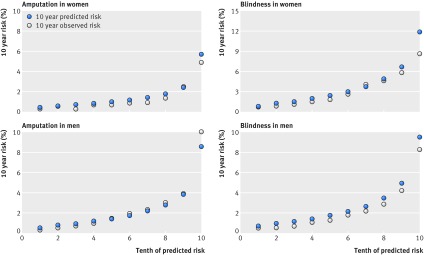
Fig 5 Mean predicted risks and observed risks of blindness and lower limb amputation at 10 years by 10th of predicted risk, applying equations to all men and women in CPRD validation cohort